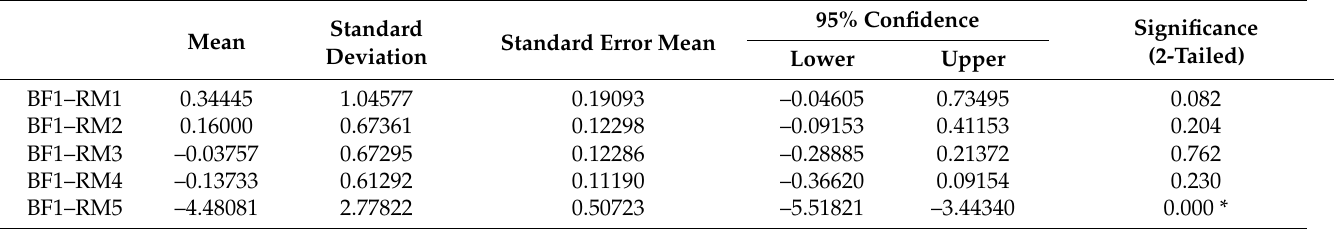
Table 3. Paired t -test for band force and 1 − RM.